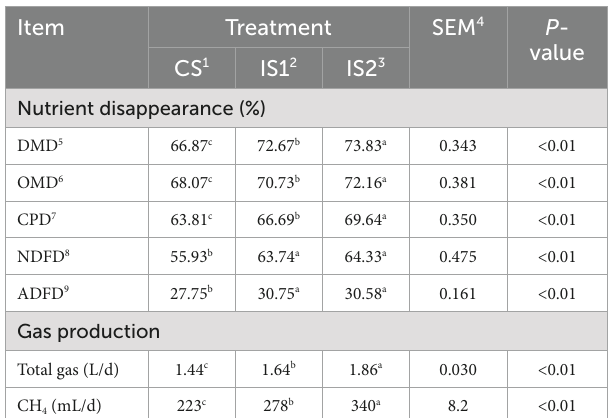
TABLE 3 Influences of different stirring times on nutrient disappearance rates and gas